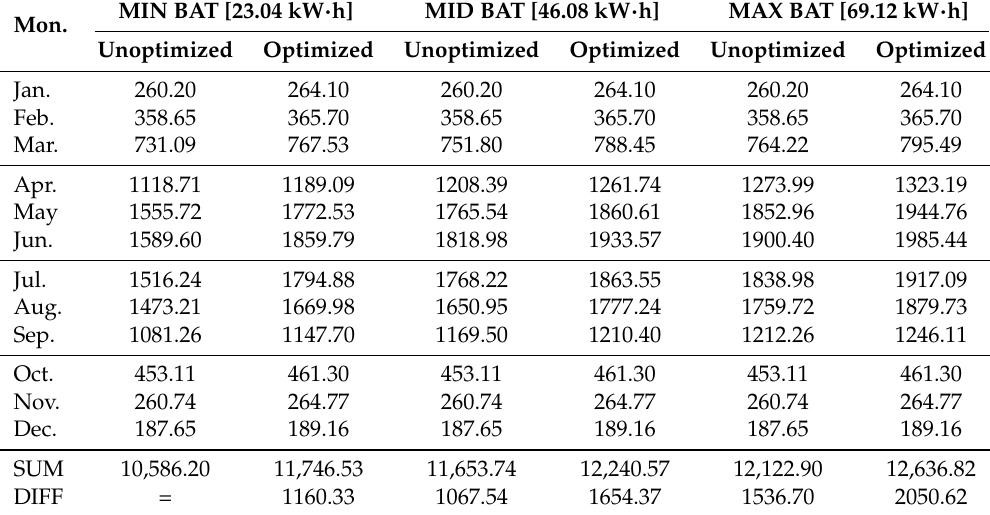
Table 6. Monthly energy savings in kWh calculated for each solution to compare their efficiency applying MIN _ charge scenario. SUM represents the total saving of the given solution during the year. Mon.